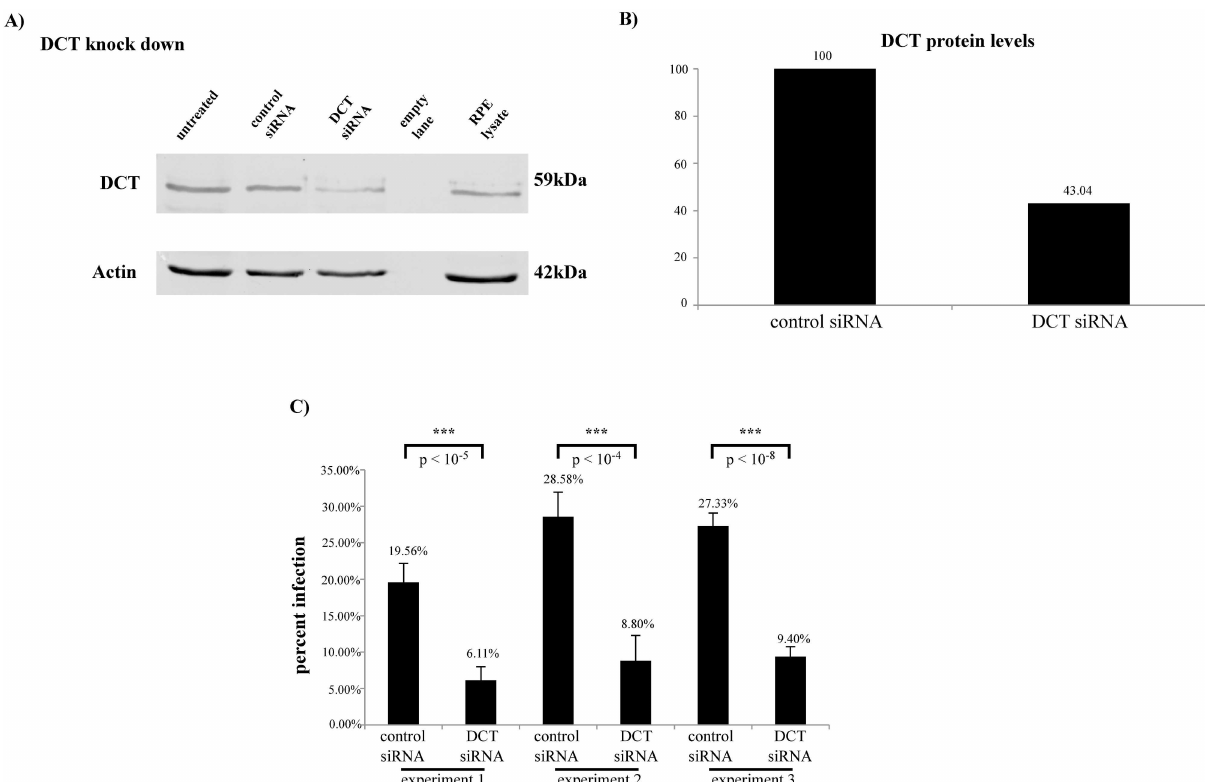
Fig 1. DCT depletion leads to a significant decreasein HPV infection in HaCaTs. (A) DCT antibodyincubationshows the partial DCT knockdownin DCT siRNA treated cells. Actin was used as the loadingcontrol. (B) DCT band intensity for control and DCT siRNA treated cells was normalized to corresponding actin measurements. DCT protein levels decreased by 57% in DCT siRNA treated cells. (C) HPV16 PsV infection significantly decreasedin DCT knockdown HaCaTs in three independentexperiments comparedto control siRNA treated cells (two-tailedt-test, p-values:0.00000135,0.000017 and 0.0000000022). Infection was quantified by flow cytometry. Error bars show the standard deviationof six experimental replicates in which 10,000 cells were analyzedfor GFP expressionto obtainthe percent of infected cells.